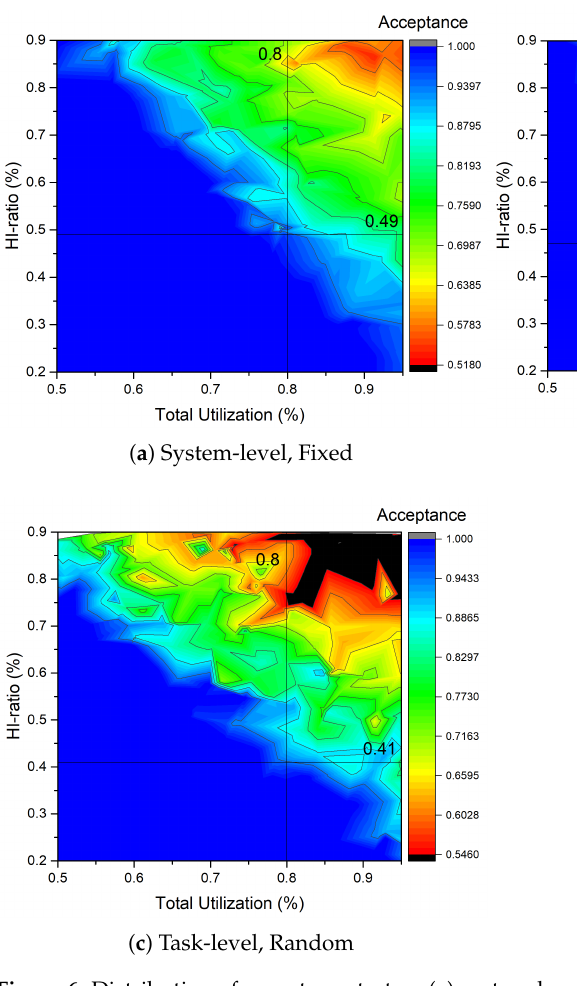
Figure 6. Distribution of acceptance test on ( a ) system-level MC scheduler (EDF-VD) and ( b , c ) task- level MC scheduler (MC-ADAPT) with fixed (2.0 times) and random (average 2.0 times) replen- ishment of low criticality runtime. The result with the ( c ) random task-level MC scheduler has approximately 0.4 maximum HC ratio on 0.8 total utilization, which is approximately 20% of the HC ratio loss compared to the ( a , b ) fixed conditions having 0.5 HC ratio acceptance. In the figures, total utilization starts at 0.3, and an acceptance less than 1.0 is considered as